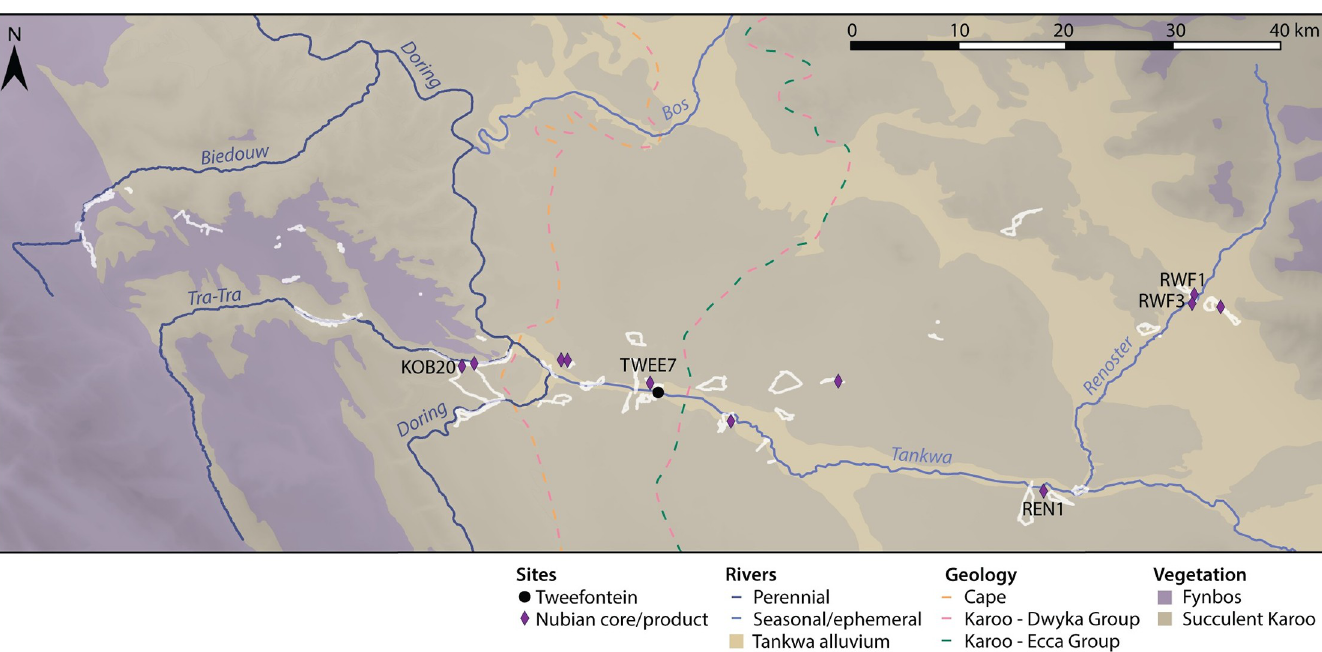
Fig 14. Map of occurrences of Nubian technology in the Tankwa Karoo. Survey walk paths are shown in white. Open-source spatial data from NaturalEarthData.com, NASA SRTM Version 3.0, and the South African National Biodiversity Institute (bgis.sanbi.org). https://doi.org/10.1371/journal.pone.0241068.g014 (Fig 17F and 17G). The Olifants River core is the apparent outlier to the geographic and envi- ronmental pattern that is emerging for Nubian technology, situated some distance from the Tankwa Karoo (70 km from Tweefontein) to the west of the Cederberg Mountains, and in a Fynbos Biome setting on the banks of a reliable perennial river. However, this distance is small when considered within the context of hunter-gatherer mobility ranges and wider regional technological trends. Thus, current evidence suggests that Nubian technology occurs geo- graphically to the east or inland side of the Cape Fold Mountain belt, in areas with seasonal